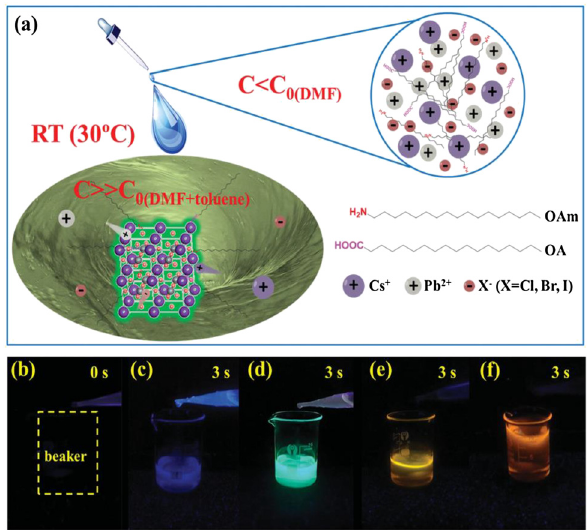
Figure10: SchematicofRTformationofIPQDs(CsPbX 3 (X=Cl,Br,I)). (a) The SR can be fi nished within 10 s through transferring the Cs + , Pb 2 + ,andX − ionsfromthesolubletoinsolublesolventsatRTwithout any protecting atmosphere and heating. C: ion concentration in differentsolvents. C 0 saturatedsolubilitiesinDMF,tolueneormixed solvents (DMF + toluene). (b) Clear toluene under a UV light. Snapshotsoffourtypicalsamplesaftertheadditionofprecursorion solutions for 3 s, blue (c, Cl:Br = 1), green (d, pure Br), yellow (e, I:Br = 1), and red (f, I:Br = 1.5), respectively